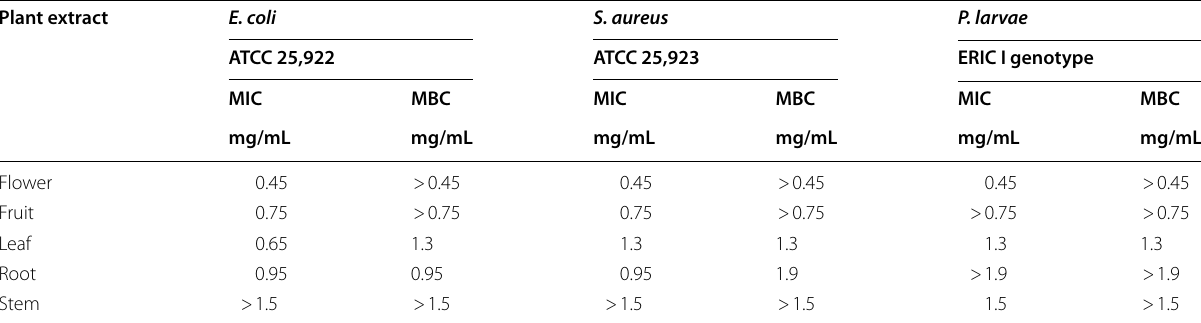
Table 2 Minimum inhibitory concentration (MIC) and minimum bactericidal concentration (MBC) of different B. insignis extracts for different